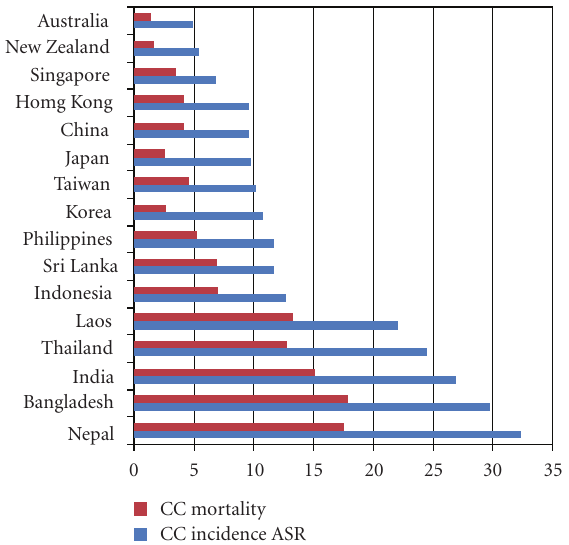
Figure 1: Incidence and mortality rates (per 100,000 women) due to cervical cancer (CC) in AOGIN country members (source Globocan at